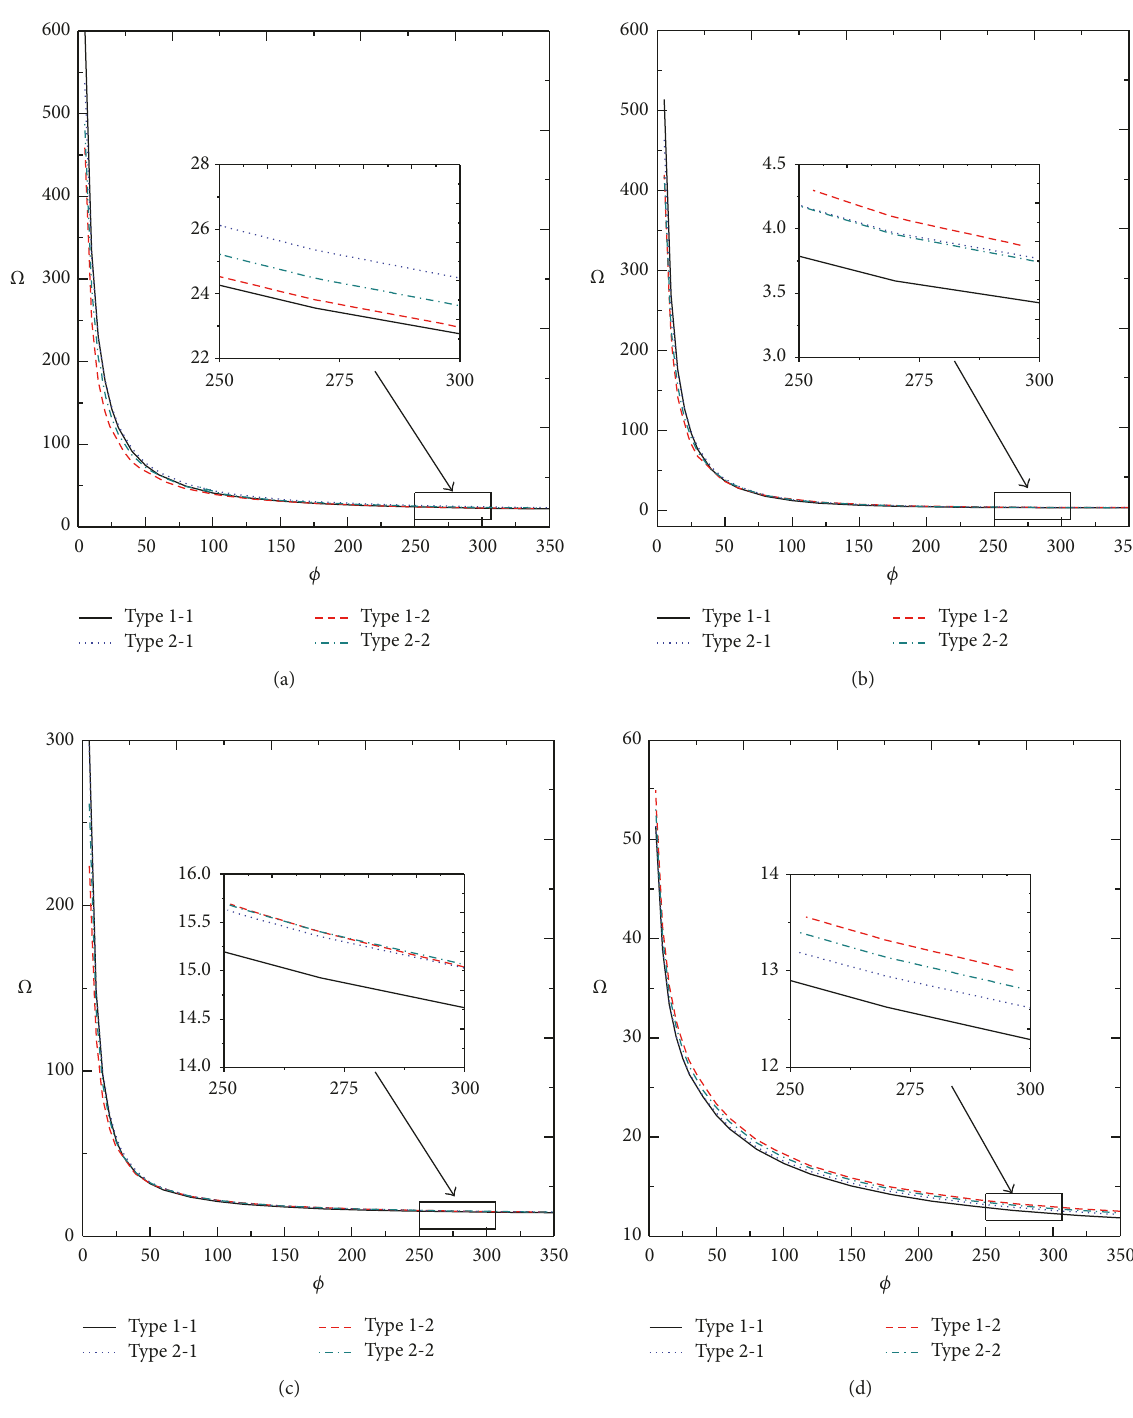
Figure 12: Variations of fundamental frequency parameter Ω of circular sector plate against different sector angles ( ℎ/𝑅 1 = 0.2, 𝜙 = 120 ∘ , and 𝑝 1 = 𝑝 3 = 5, 2-2-1): (a) CCC (b) CFC; (c) CE 1 E 1 ; (d) E 3 E 3 E 3